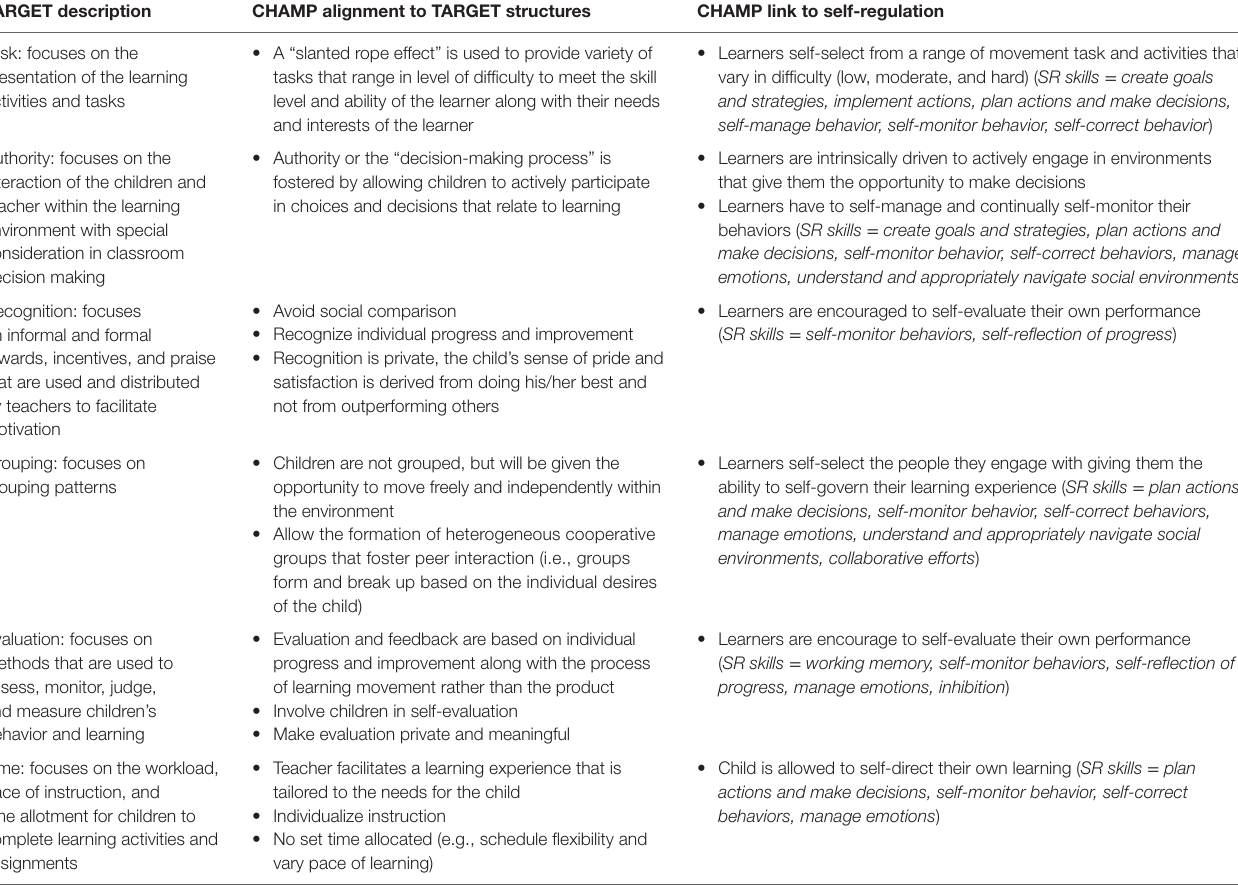
TaBle 1 | Description of TargeT structures and chaMP